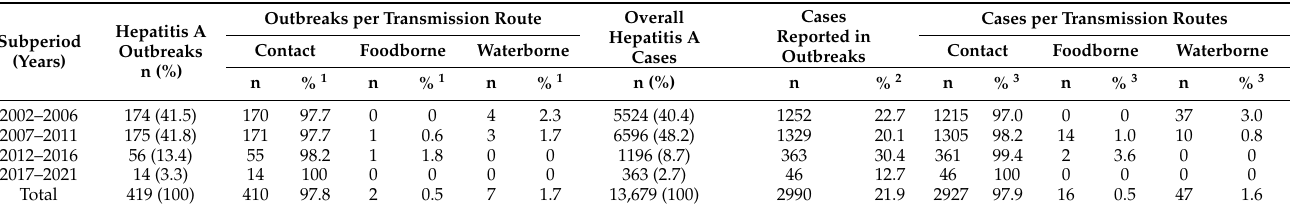
Table 2. Reported cases and outbreaks of hepatitis A in Serbia,